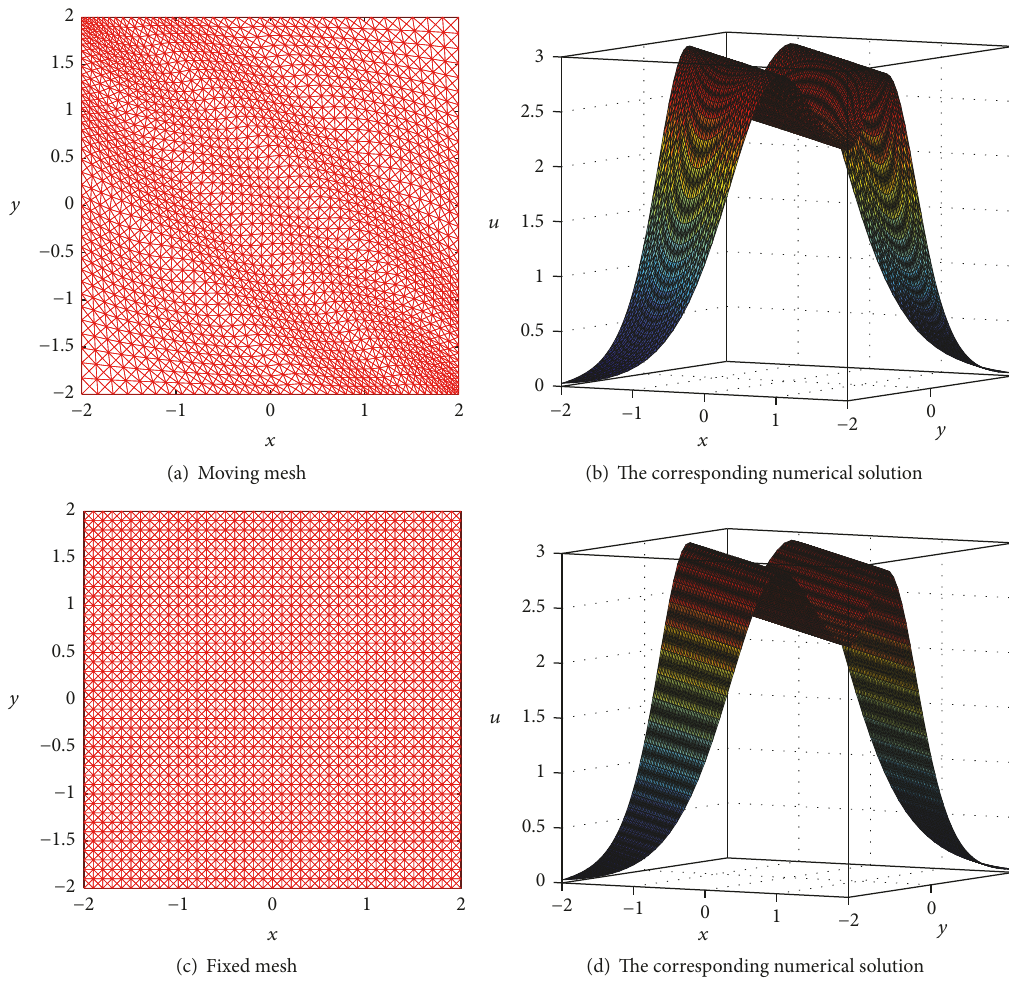
Figure 7: Example 4. Meshes (a, c) and the corresponding numerical solutions (b, d) with 𝑁 = 6400